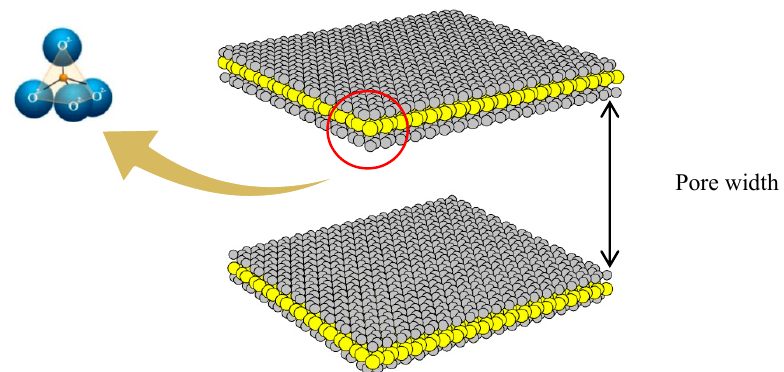
Figure 2. The solid model of porous silica glass used in this study; each wall consists of an assemblage of SiO 4 crystals . In the figure, yellow spheres and grey spheres represent silicon and oxygen atoms, respectively.